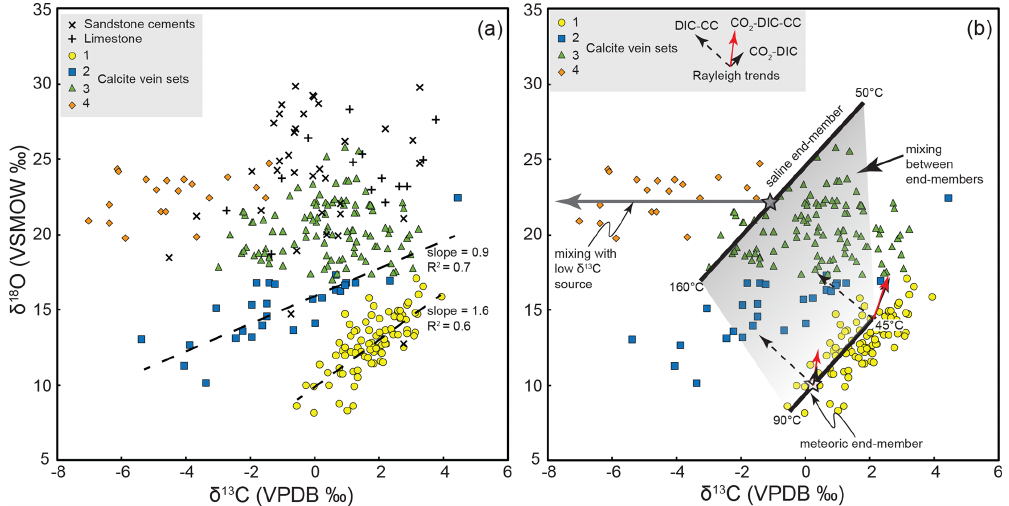
Figure 4. (a) Calcite δ 18 O VSMOW and δ 13 C VPDB values for veins and host rocks along the Hurricane fault. Host rock values are from bulk limestone samples and from calcite-cemented sandstones. The veins are divided into four veins sets for analysis. Note the trend line slopes for vein sets 1 and 2. (b) Paleofluid interpretations integrating the isotopic and fluid inclusion microthermometry results. Mixing scenarios depicted include the mixing of two end-member fluids over a range of temperature and the mixing with a low- δ 13 C CO 2 source. Also shown are the Rayleigh fractionation trends (arrows) due progressive precipitation of calcite from water-dissolved inorganic carbon (DIC-CC), progressive CO 2 loss from the water-dissolved inorganic carbon (CO 2 -DIC), and the combined effects of CO 2 degassing and calcite precipitation (CO 2 -DIC-CC). The Rayleigh trends are computed for F from 1 to 0 (e.g., Eq. 4).